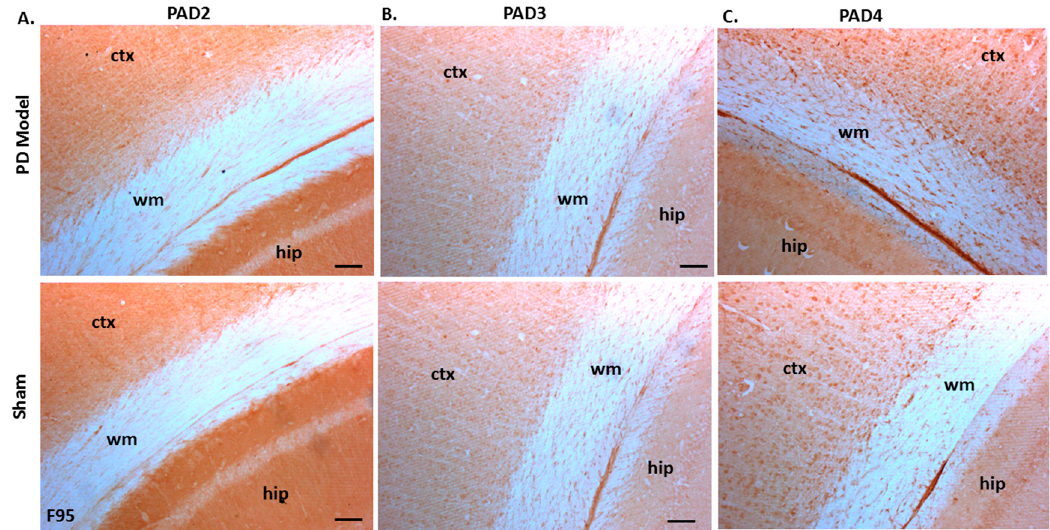
Figure 10. PAD2, PAD3, and PAD4 protein detection in pre-motor PD model and sham brain tissue. ( A ) PAD2 protein detection in cortex (ctx), white matter (wm) and hippocampus (hip) of sham and pre-motor PD models. ( B ) PAD3 protein detection in cortex, white matter, and hippocampus of shams and pre-motor PD rats. ( C ) PAD4 protein detection in cortex, white matter and hippocampus of shams and pre-motor PD rats. The scale bars indicate 100 µ m in all figures (ctx = cortex, hip = hippocampus, wm = white matter).